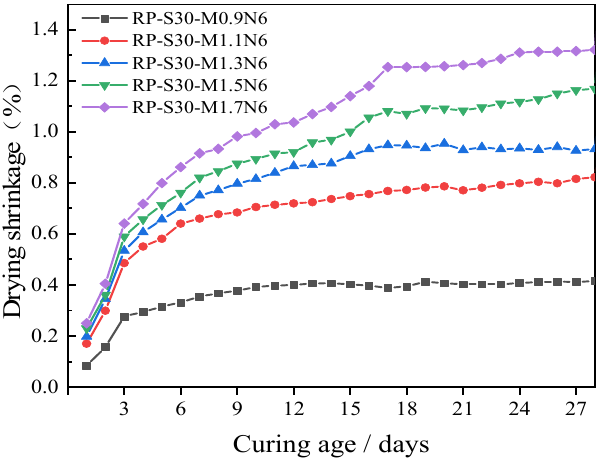
Figure 7. Drying shrinkage results of RPSG with different moduli.